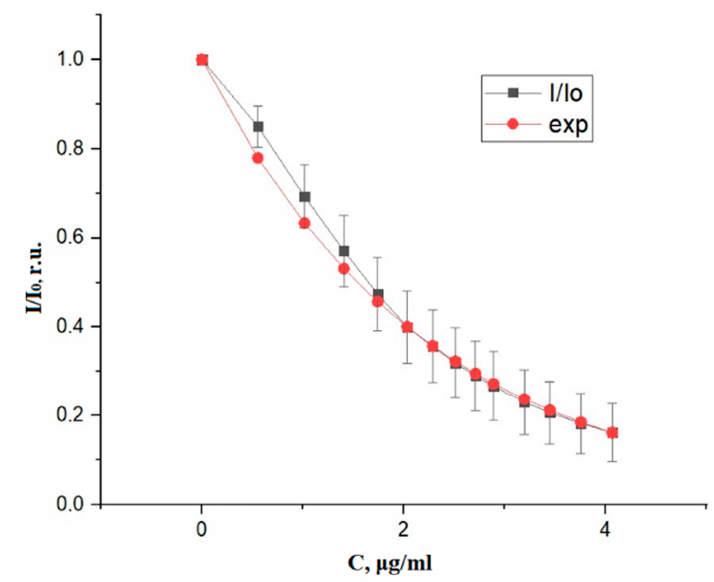
Figure 4. Ratio of the intensity of the light transmitted by dye albumin solution to intensity of light transmitted by solution of albumin and its approximation by an exponential function. An experiment with a 20% albumin solution in the dye concentration range showed agreement with the theoretical data. However, in contrast to the experiment with water, it was not possible to choose an exponent that could approximate the beginning of the graph at a concentration near zero. At the second stage of the measurements, we studied blood plasma samples from patients with liver pathology. Plasma samples were taken from 23 patients with liver pathology as part of routine ICG serial blood testing at the department of anesthesiology and intensive care of Russian Research Center of Radiology and Surgical Technologies. Plasma samples form a series each consisting of a set of measurements during the study of one patient. We have studied the samples taken before administering the dye, which are used to determine the optical density of the blood plasma itself. The intensity I 0 of the light passing through the plasma without dye allows to calculate the relative